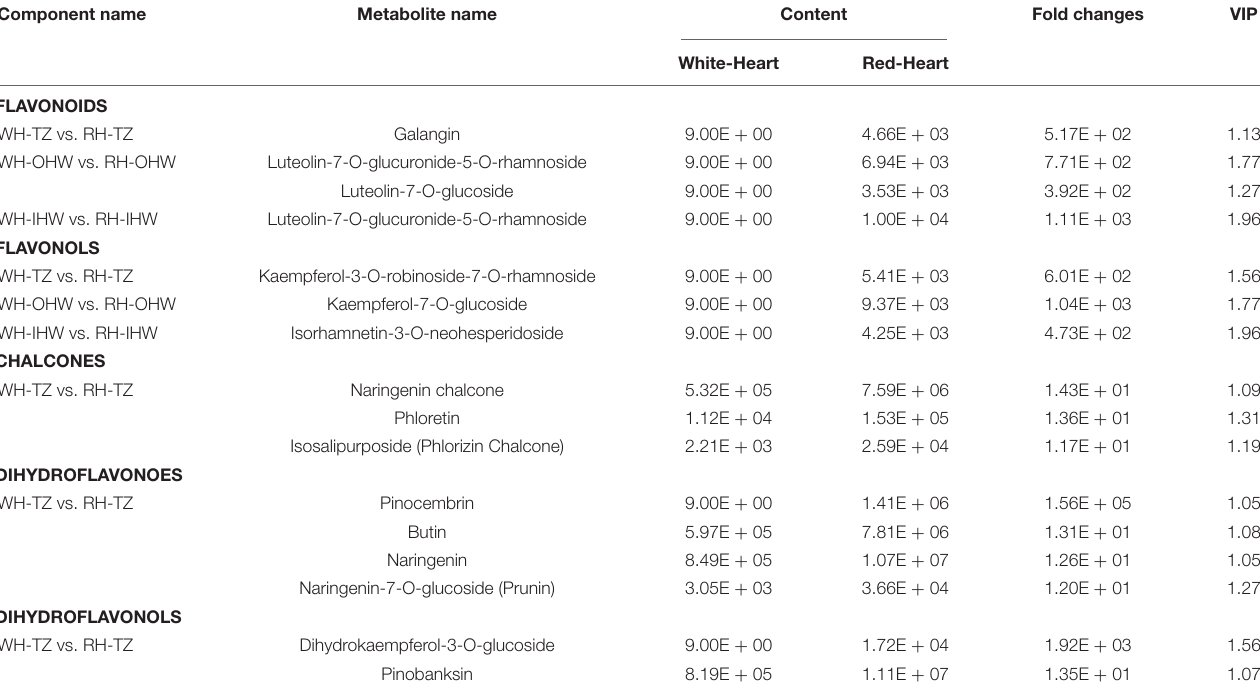
TABLE 1 | Differentially accumulated flavonoid compounds in the wood of “White-Heart” and “Red-Heart” Chinese